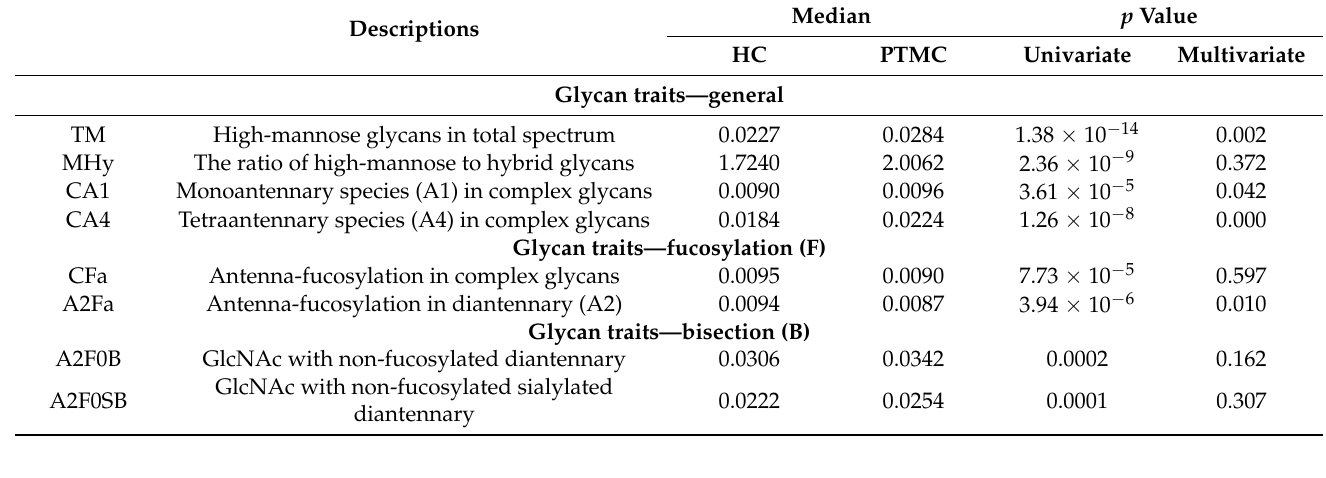
Table 2. The univariate and multivariate analysis of differentially expressed derived N -glycan traits, helping to distinguish between papillary thyroid microcarcinoma (PTMC) and healthy controls (HC) groups.